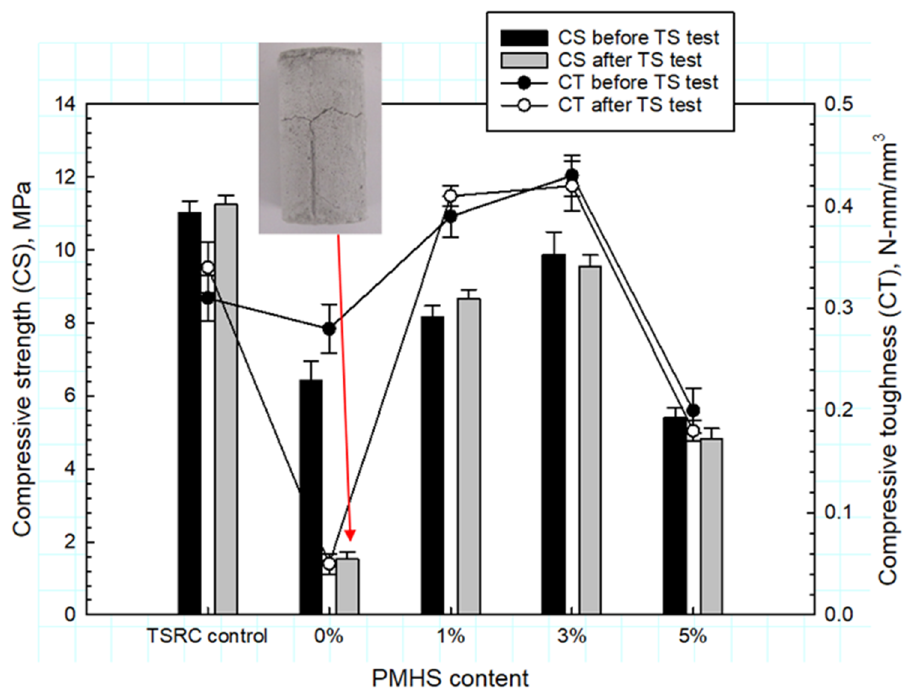
Figure 20. Compressive strength and toughness of 250 °C-autoclaved TSRC control and CAC lightweight cements containing 0, 1, 3, and 5% PMHS-treated FCS before and after the TS test.